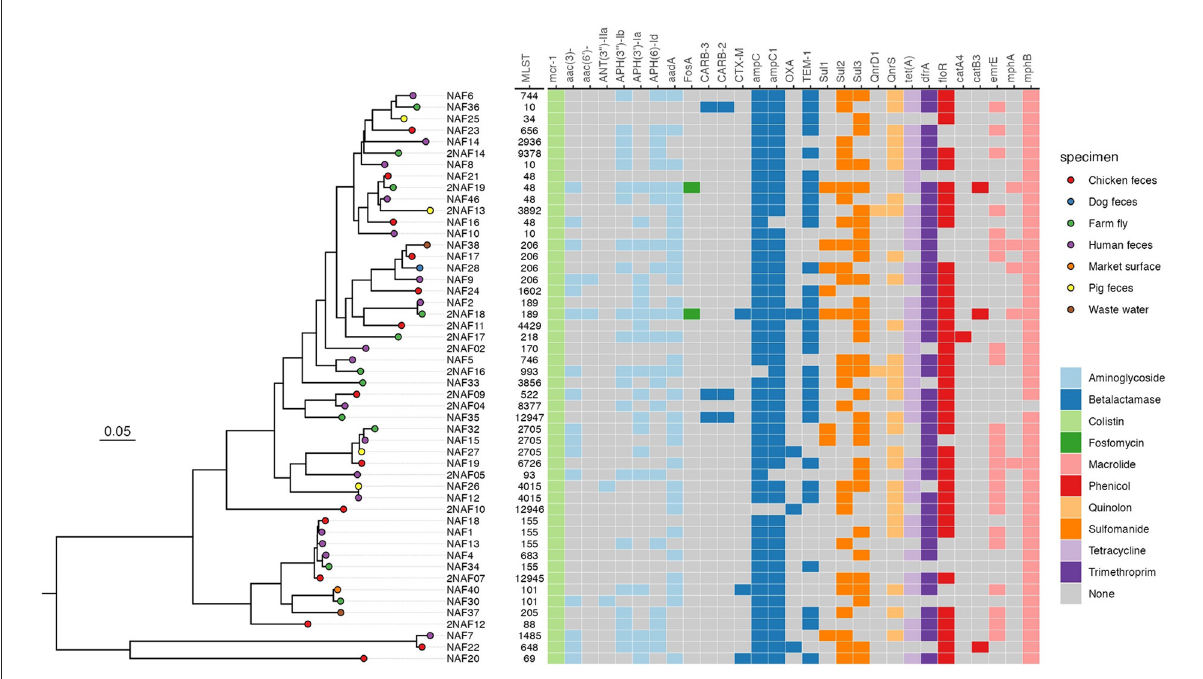
FIGURE2 Maximum likelihood phylogenic analysis of 50 MCRPEC isolates from farms in Ha Nam. The heat map represents the AMR genotype of 50 MCRPECs.